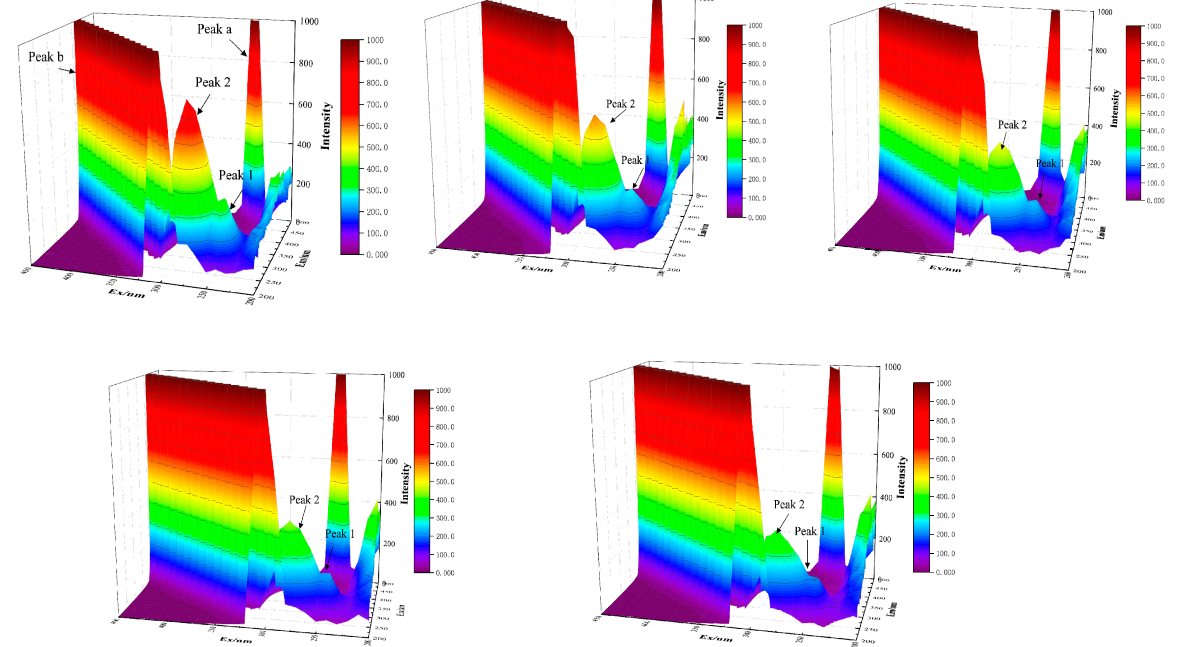
Figure 4. Three-dimensional fluorescence spectra of the interaction between catechins and IgY at different mass concentrations. different mass